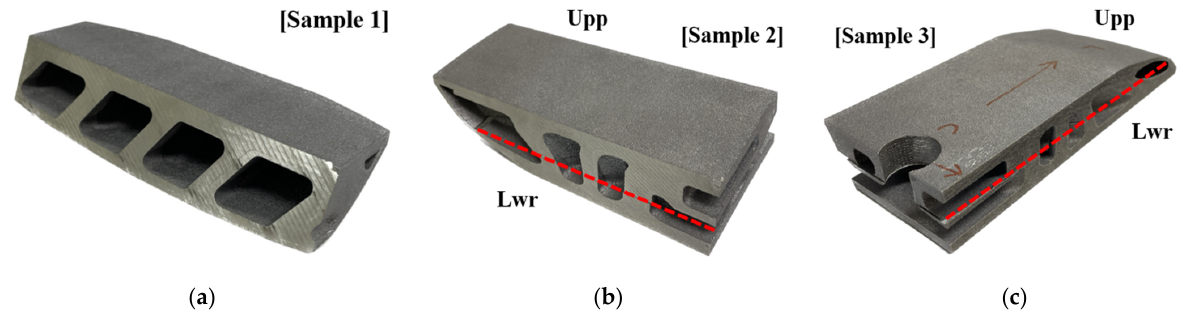
Figure 19. Fabricated samples corresponding to extracted samples. Samples were fabricated using AlSi7Mg metal powder via LPBF: ( a ) sample 1; ( b ) sample 2; ( c ) sample 3.